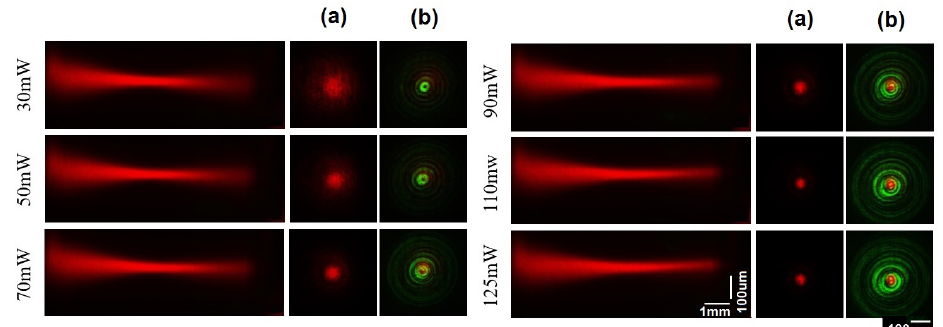
Figure 6. Propagation of the red probe collinear with m = 1 BV for various input powers, as labeled on the vertical axes. Leftmost photographs in each panel: x-z evolution along the sample. ( a ) Transverse intensity profile of red probe at the output; ( b ) superimposed transverse intensity profiles of the red probe and the green pump at the